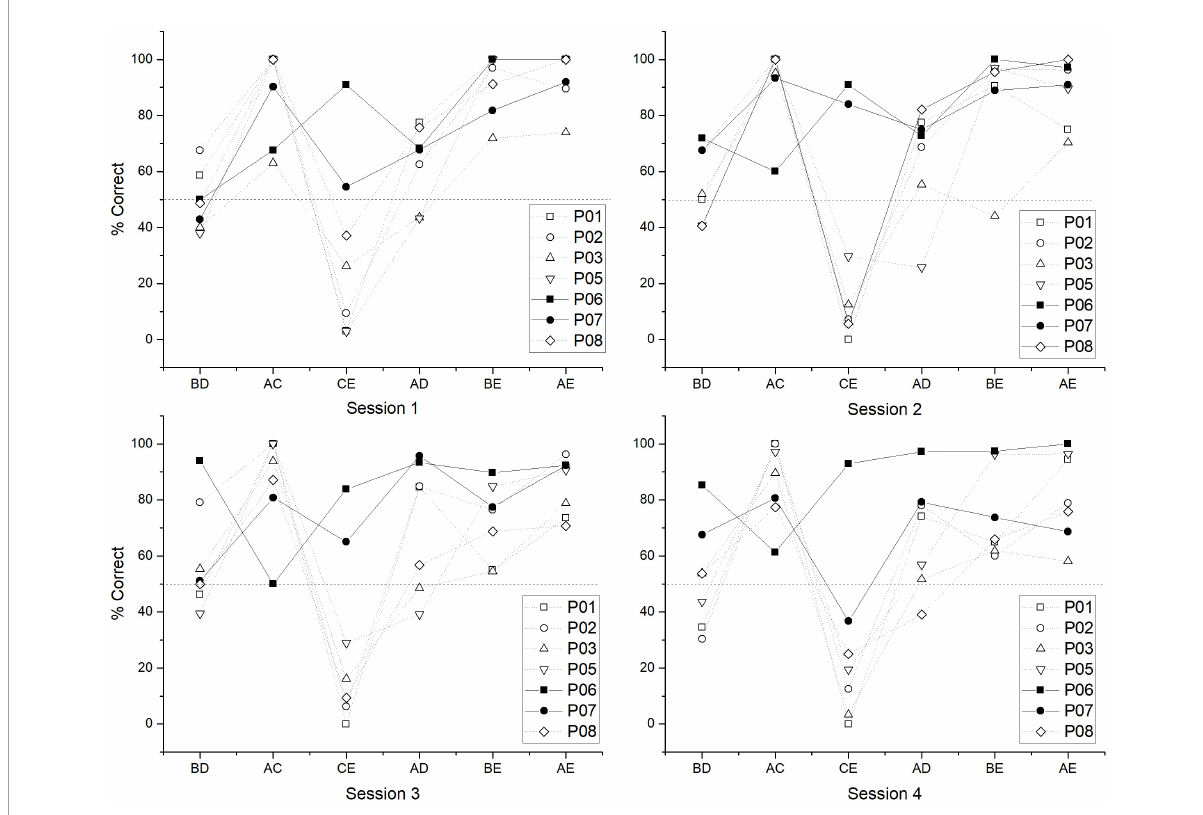
FIGURE6 Individual performance for each test session of test 1. Closed symbols correspond to C + learners and open symbols to non C + learners.